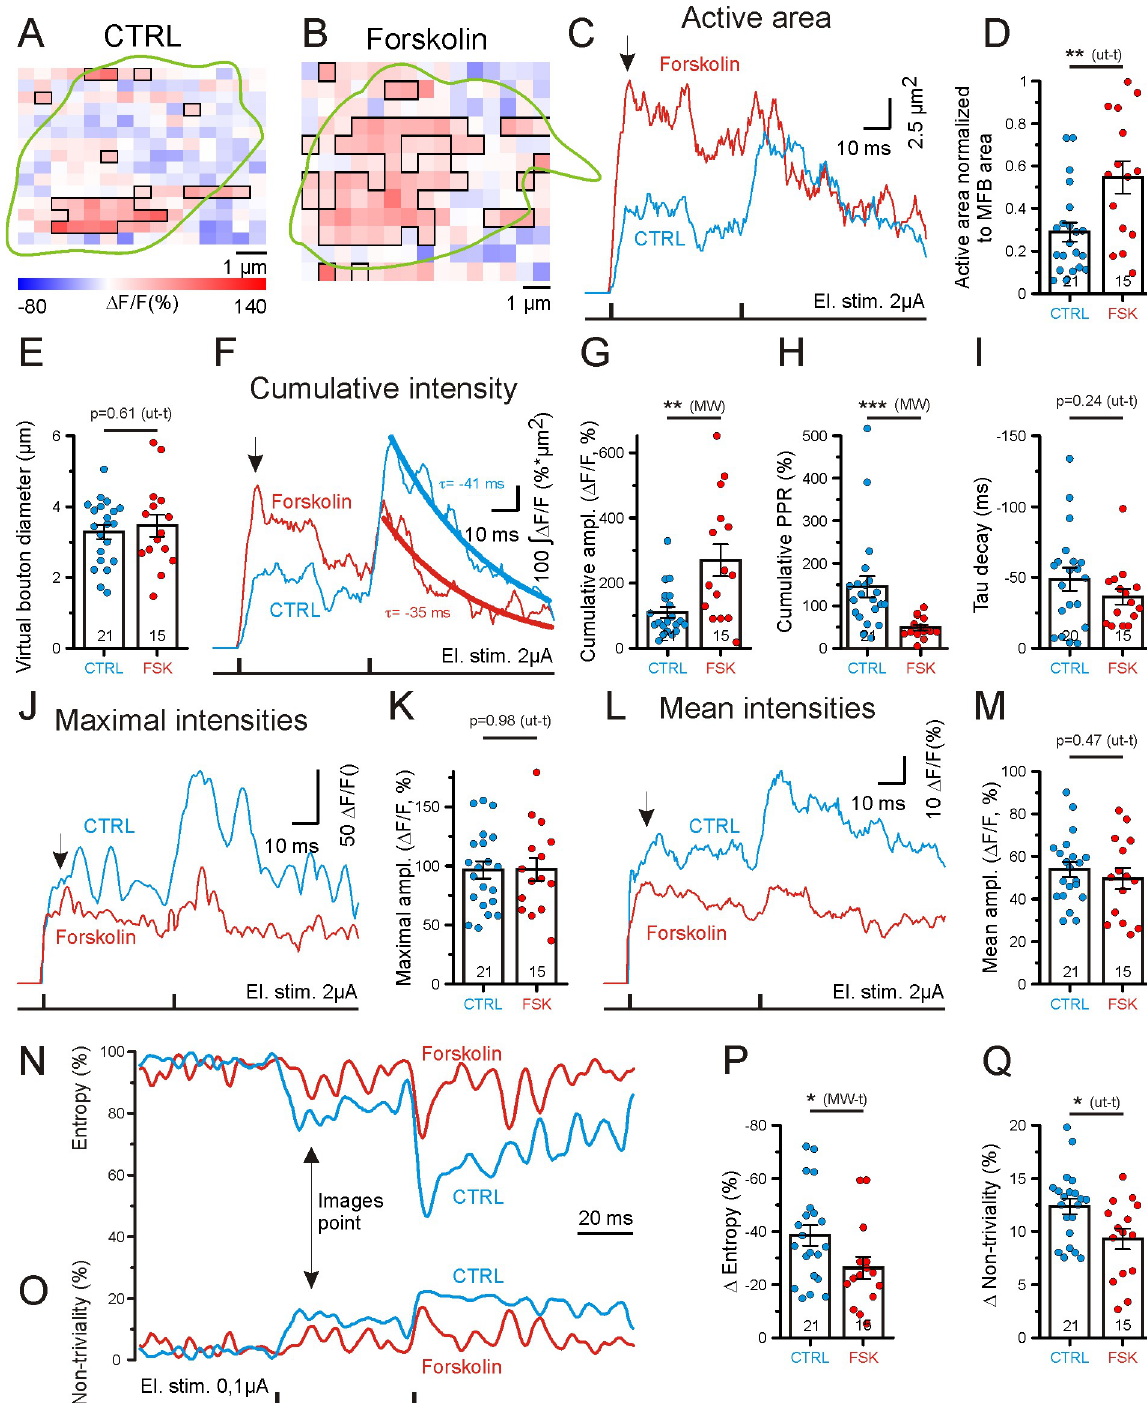
Fig 2. Forskolin increases the presynaptic surface area of glutamate release and the spatial synchronization of glutamate release within hMFBs. (A and B) Example images illustrating the spatial distribution of Δ F/F signals for 2 different hMFBs in control conditions (A) and in the presence of forskolin (B). The manually drawn green curve contours the profile of the recorded hMFB, based on the high-resolution image acquired before the stimulation experiment. The Δ F/F signals are taken at the peak responses to a first electrical stimulation (the time point is indicated by a black arrow in (C, F, J, L, N, and O) AU : InthelegendtoFig 2 ; Ichangedblackarrowin ð C ; E ; I ; K Þ toblackarrowin ð C ; F ; J ; L ; N ; andO Þ : Ifthisisnotcorrect ; pleaseedit : . Suprathreshold pixels (pixels with Δ F/F intensities more than 3 × SD of the baseline signal, i.e., 50 ms before the stimulation) are contoured with a black line and represent the active area. Note the larger fraction of red pixels in the presence of forskolin (B) at equal intensities. (C) Example traces representing active area (the area of suprathreshold pixels) dynamics for